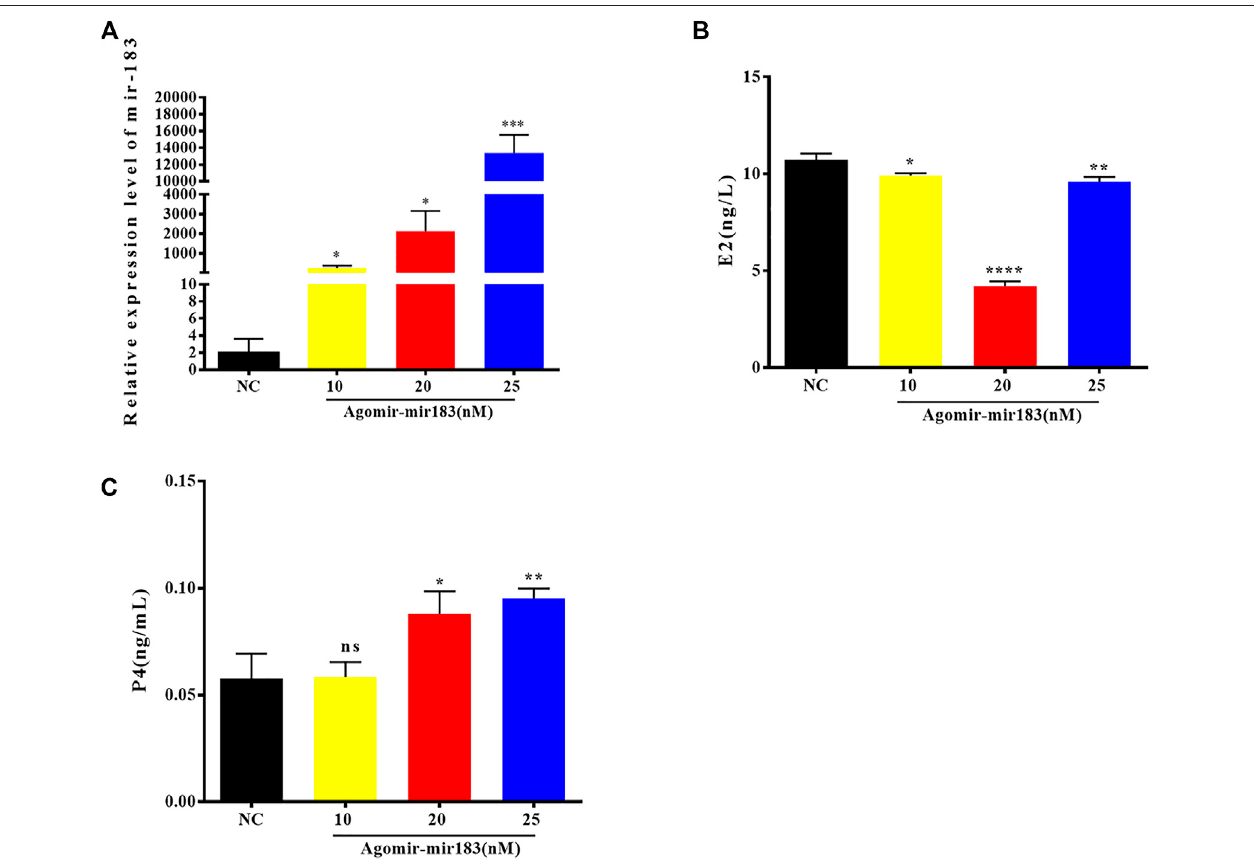
FIGURE 4 | Overexpression ef fi ciency of miR-183 (A) Assessment of overexpression ef fi ciency by qPCR. (B, C) Compared with NC, 20 nM miR-183 agomir signi fi cantly reduced the synthesis of E2 and promoted the synthesis of P4 (NS: no signi fi cant difference; *, p < 0.05; **, p < 0.01; ***, p < 0.001, n (cid:1) 3).